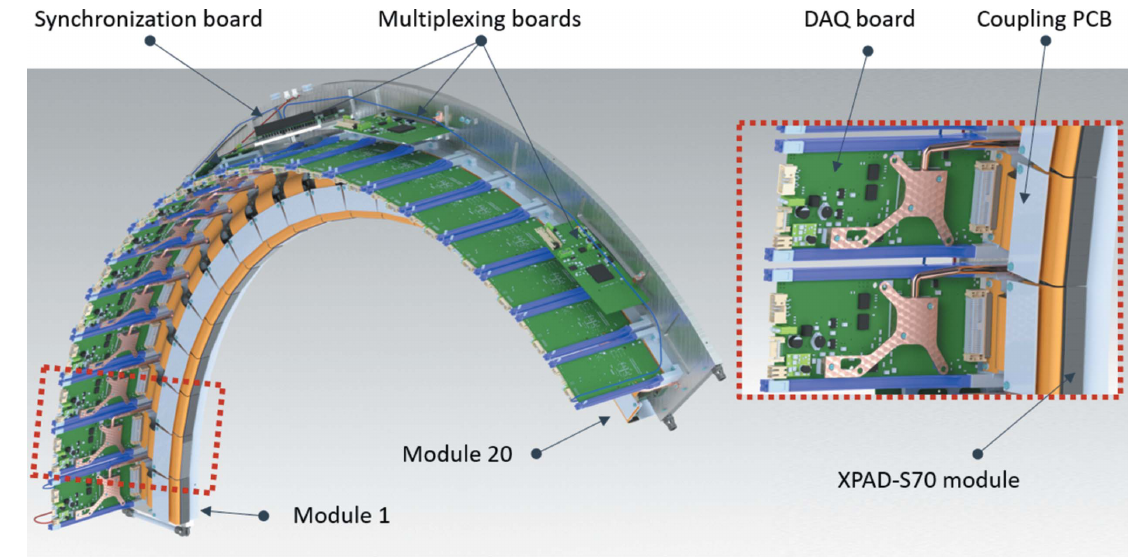
Figure 4 CirPAD frame and mounting of the XPAD-S70 modules. The 20 XPAD-S70 modules associated with the 20 FPGA acquisition board (DAQ) are also shown. The multiplexing boards are placed behind. The power supply and cables are not shown. The right-side inset shows a magnification of two consecutive modules.